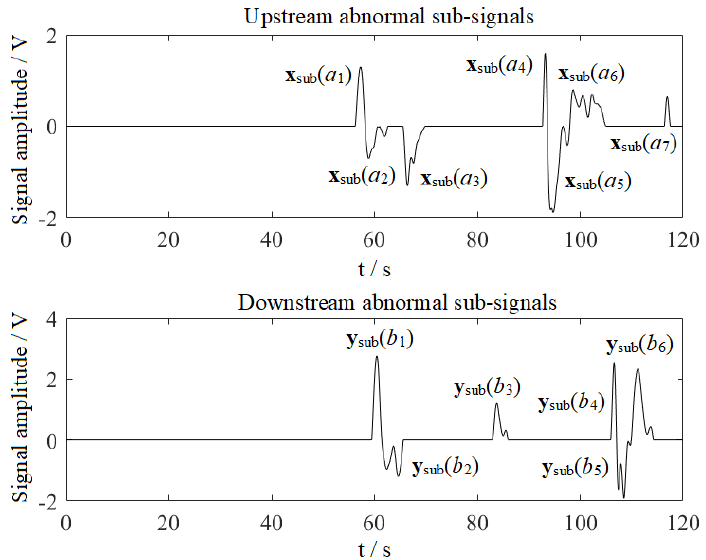
Figure 13. Isolated abnormal